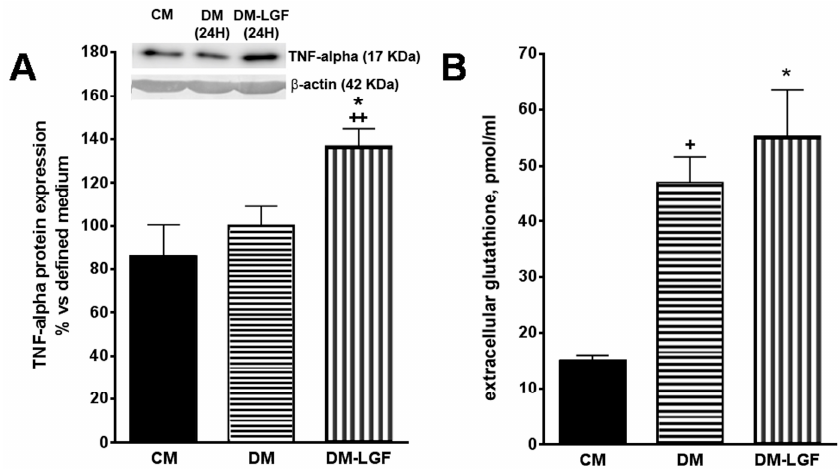
Figure 5. E ff ects of LGF on tumor necrosis factor alpha (TNF-alpha) protein expression and extracellular glutathione modulation in mesencephalic glial cultures. ( A ) shows how 100 pg of LGF increased TNF-alpha protein expression in mesencephalic glial cultures, as compared with those cultures maintained in a defined medium for 24 h (DM) or in a complete medium containing 15% FBS (CM). ( B ) shows how the depletion of FBS increased the extracellular concentration of glutathione in glial cultures, an e ff ect that was not modulated by LGF treatment. The results represent the mean ± SEM